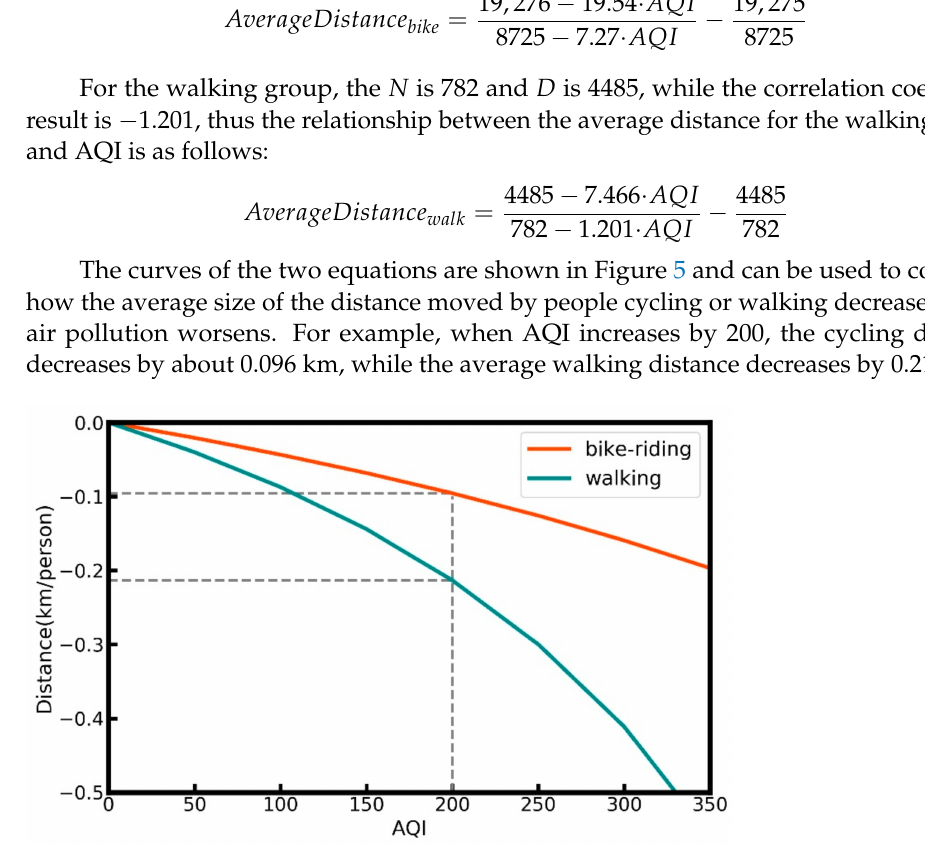
Figure 5. The relationships between AQI and average distance for people walking and